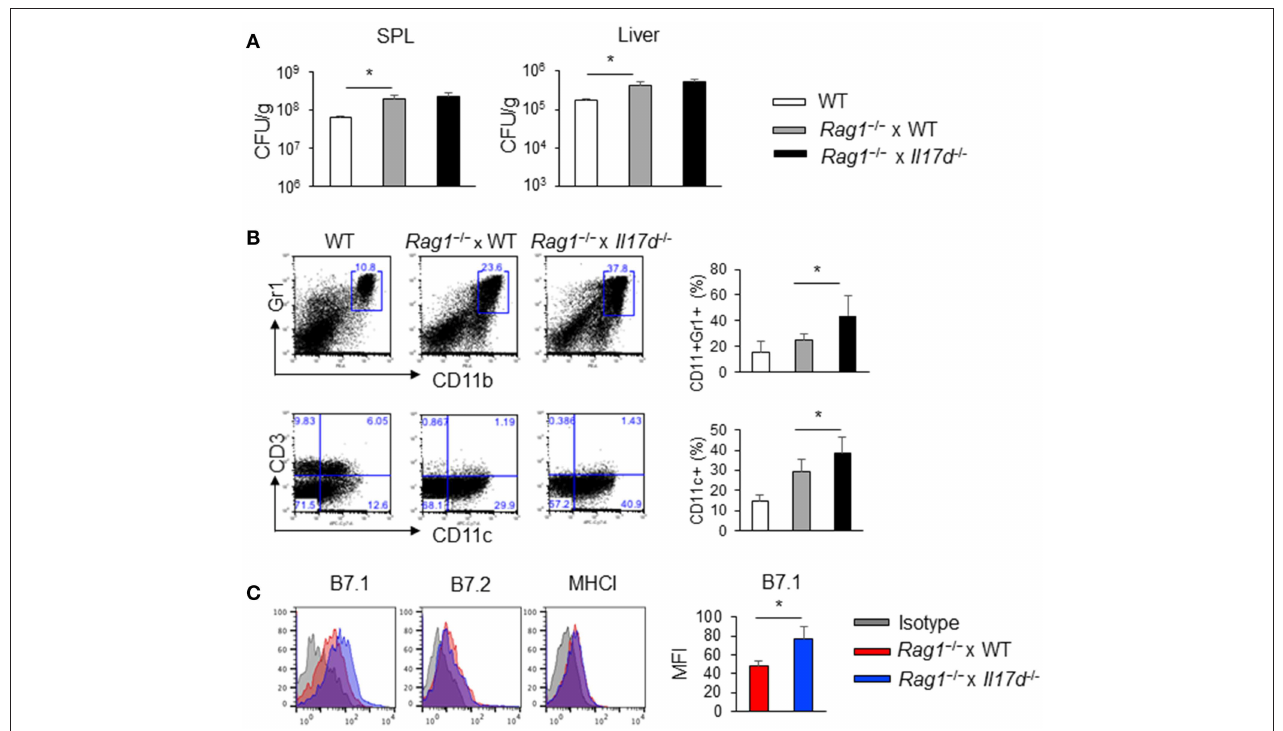
FIGURE 5 | IL-17D suppresses DC activation in Rag1 − / − mice. WT or Rag1 − / − or Rag1 − / − x Il17d − / − mice were intravenously infected with 1 × 10 4 LM-OVA on day 0. Mice were sacrificed and analyzed on day 7. (A) Bacterial burden in the spleen and liver. (B) Cellularity of CD11b + Gr1 + cells and CD11c + cells in the spleen by FACS staining. (C) DC activation markers (CD80, CD86, and MHC I) were stained by FACS. Data are representative of three independent experiments. * p ≤ 0.05.